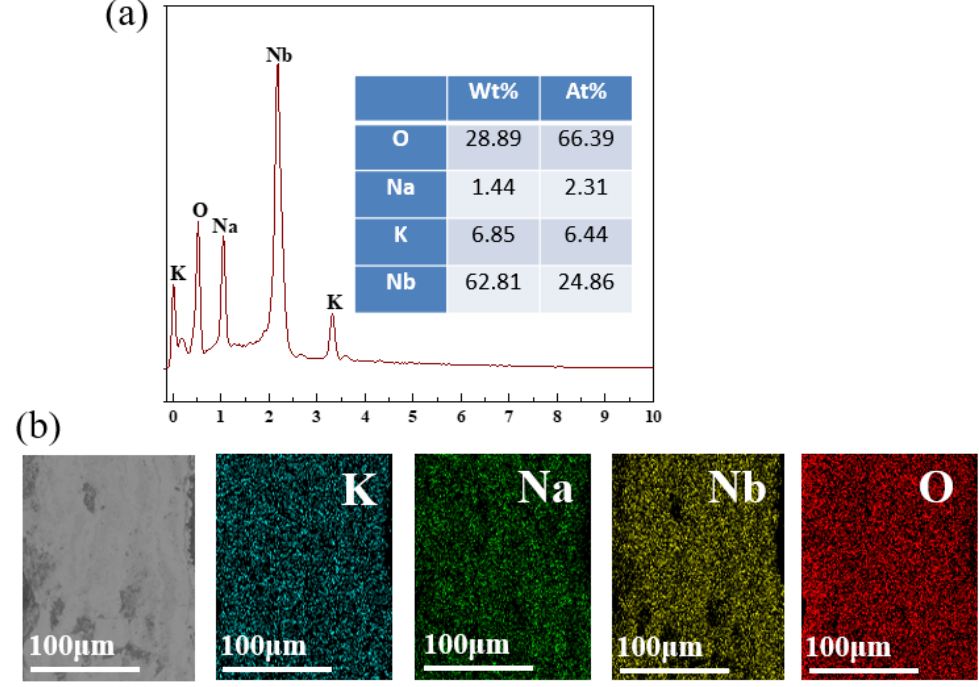
Figure 8. Energy-dispersive X-ray spectroscopy (EDS) energy spectrum of pure KNN coating. ( a ) Elemental quantitative analysis and ( b ) Elemental distribution of coating section.